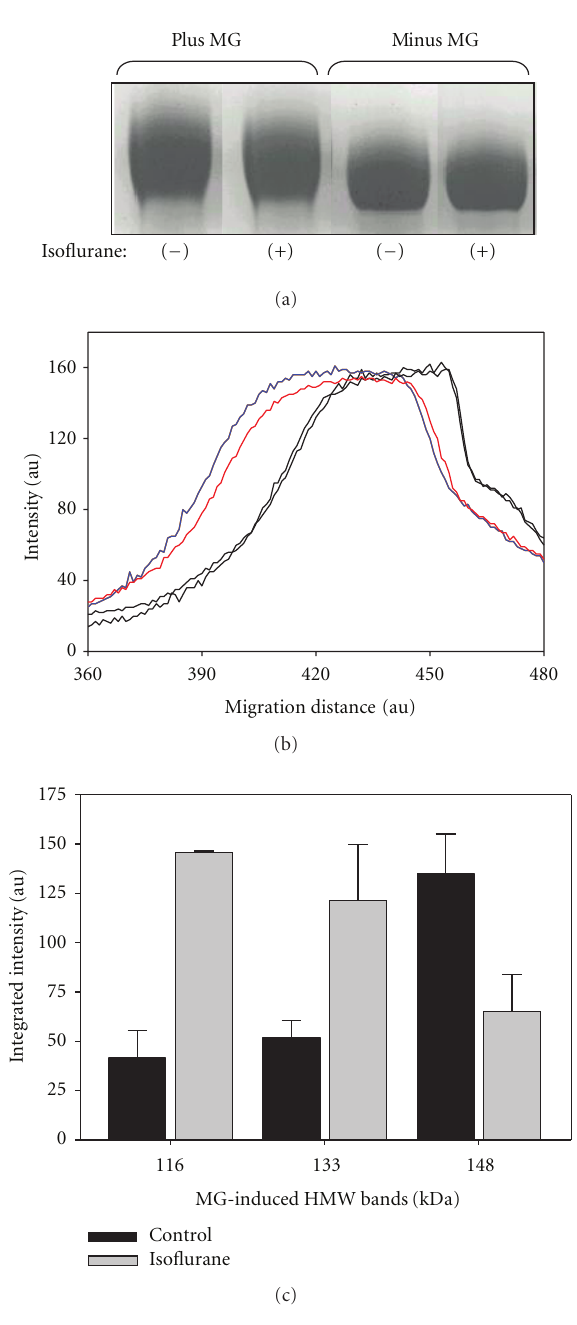
Figure 5: Electrophoretic mobility of MG-modified HSA treated with isoflurane. HSA was pretreated with isoflurane (0.3mM) prior to dilution and exposure to MG (3mM for 7 days at room temperature). Following SDS-PAGE, analysis of Coomassie-stained gels involved visual inspection (a) and densitometry (b) of the major 66kDa band. Additionally, the minor MG-induced HMW bands (c) were analyzed by integration of densitometric scans using SigmaGel. The densitometric analysis shown in (b) presents the migration changes of the major bands in (a). The migration distance in (c) represents arbitrary units of measurement that originate from the top of the gel. The color tracings are the plus MG samples that were treated (red) and untreated (blue) with isoflurane. The black tracings are the respective minus MG samples.